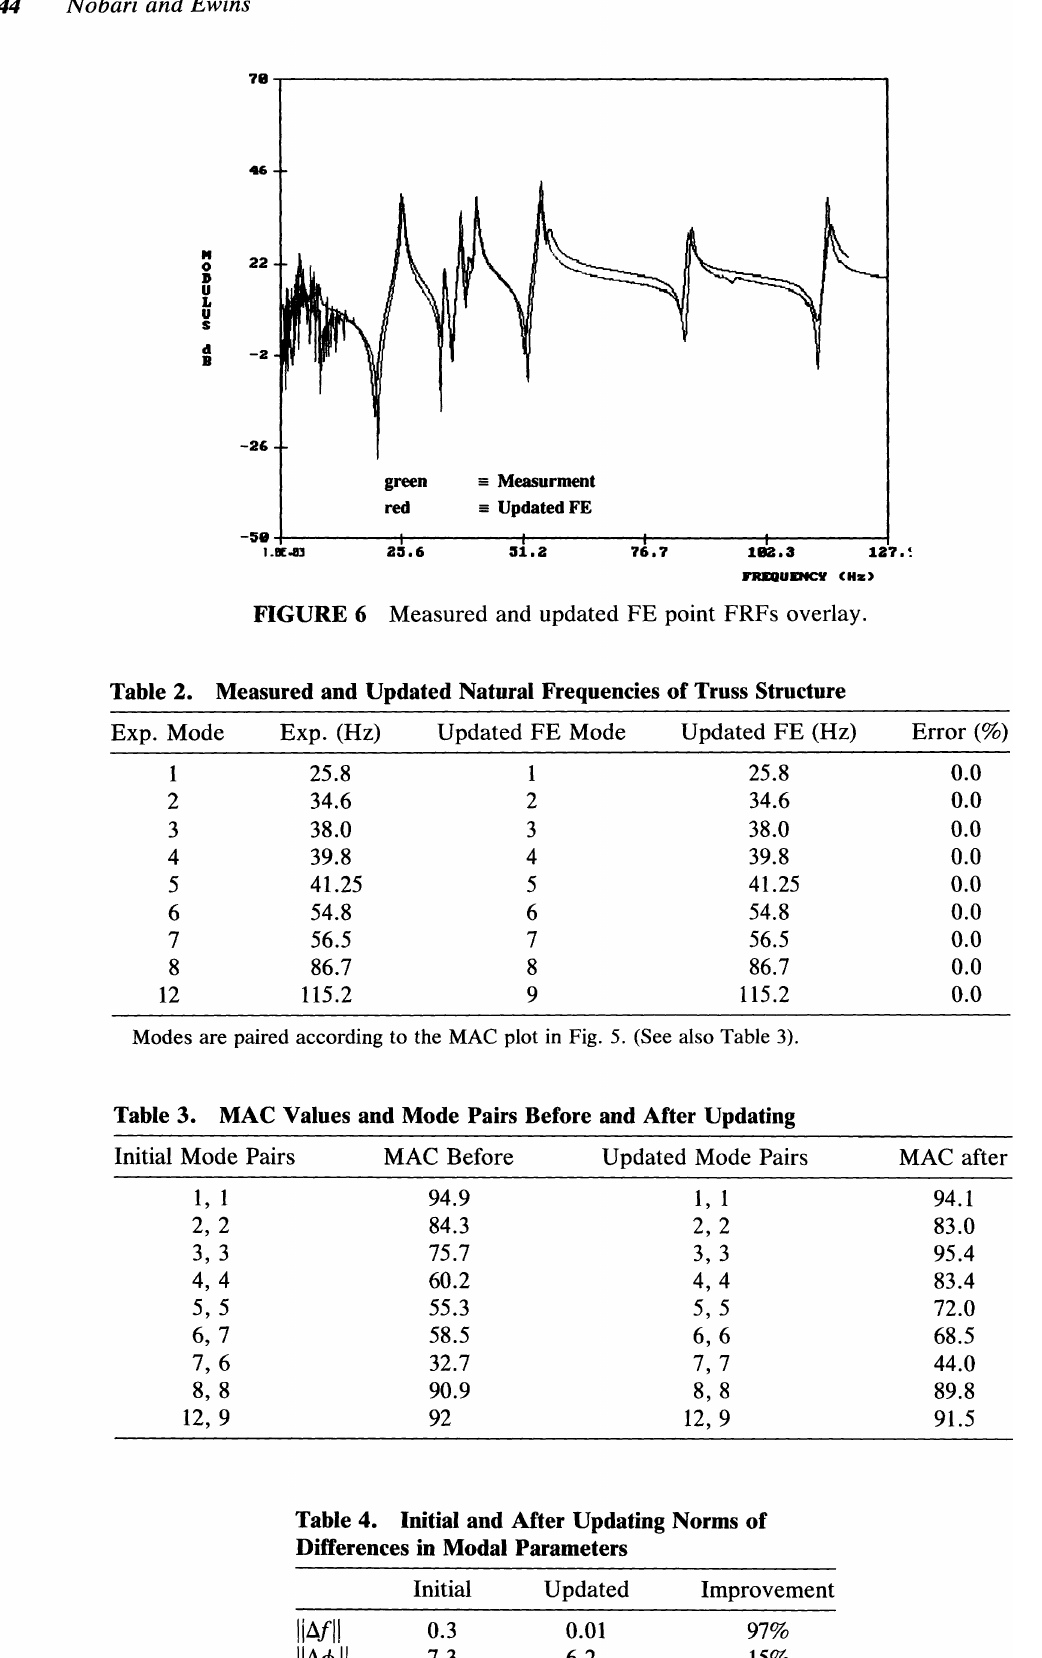
Table 3. MAC Values and Mode Pairs Before and After Updating